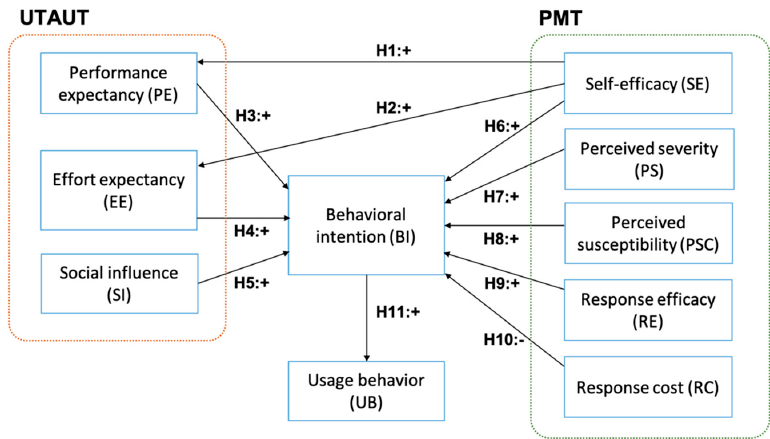
Figure 1. The research model to characterize the consumer behavior in leveraging social media for e-patient and health-related activities. The model was constructed based on the integrated theories of Protection Motivation Theory (PMT) and the Unified Theory of Acceptance and Use of Technology (UTAUT).